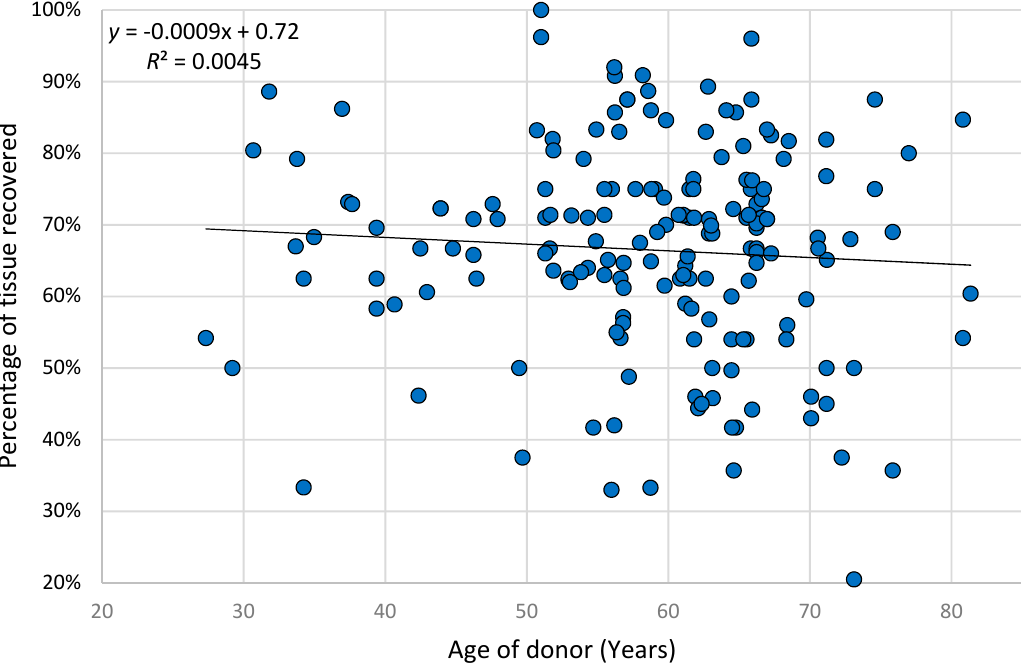
Figure 2. Percentage recovery shows little decline with age. The age of adipose tissue donors ranged from 27 years to 83 years. Regardless of donor age, there was no significant decrease in thawed tissue yield after cryopreservation.